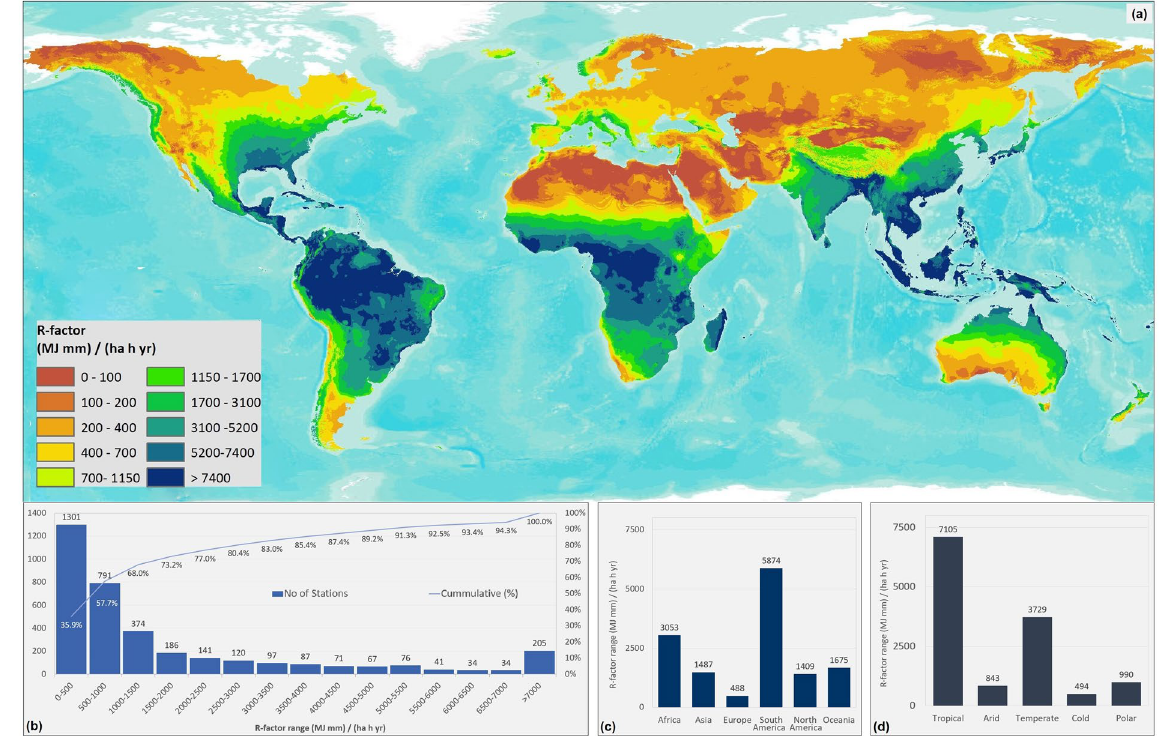
Figure 2. ( a ) Global Rainfall Erosivity map (spatial resolution 30 arc-seconds). Erosivity classes correspond to quantiles. Map generated with ESRI ArcGIS ver. 10.4 (http://www.esri.com); ( b ) number and cumulative percentage of GloREDa stations grouped by erosivity; (c) mean erosivity by continent; (d) mean erosivity by climate